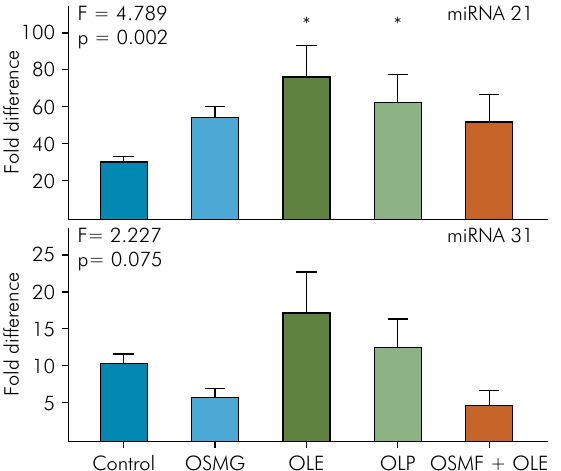
Figure 1. Mean of fold difference of miRNA-21 and miRNA 31 in